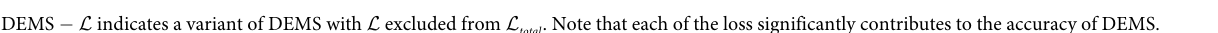
DEMS (cid:0) L indicates a variant of DEMS with L excluded from L